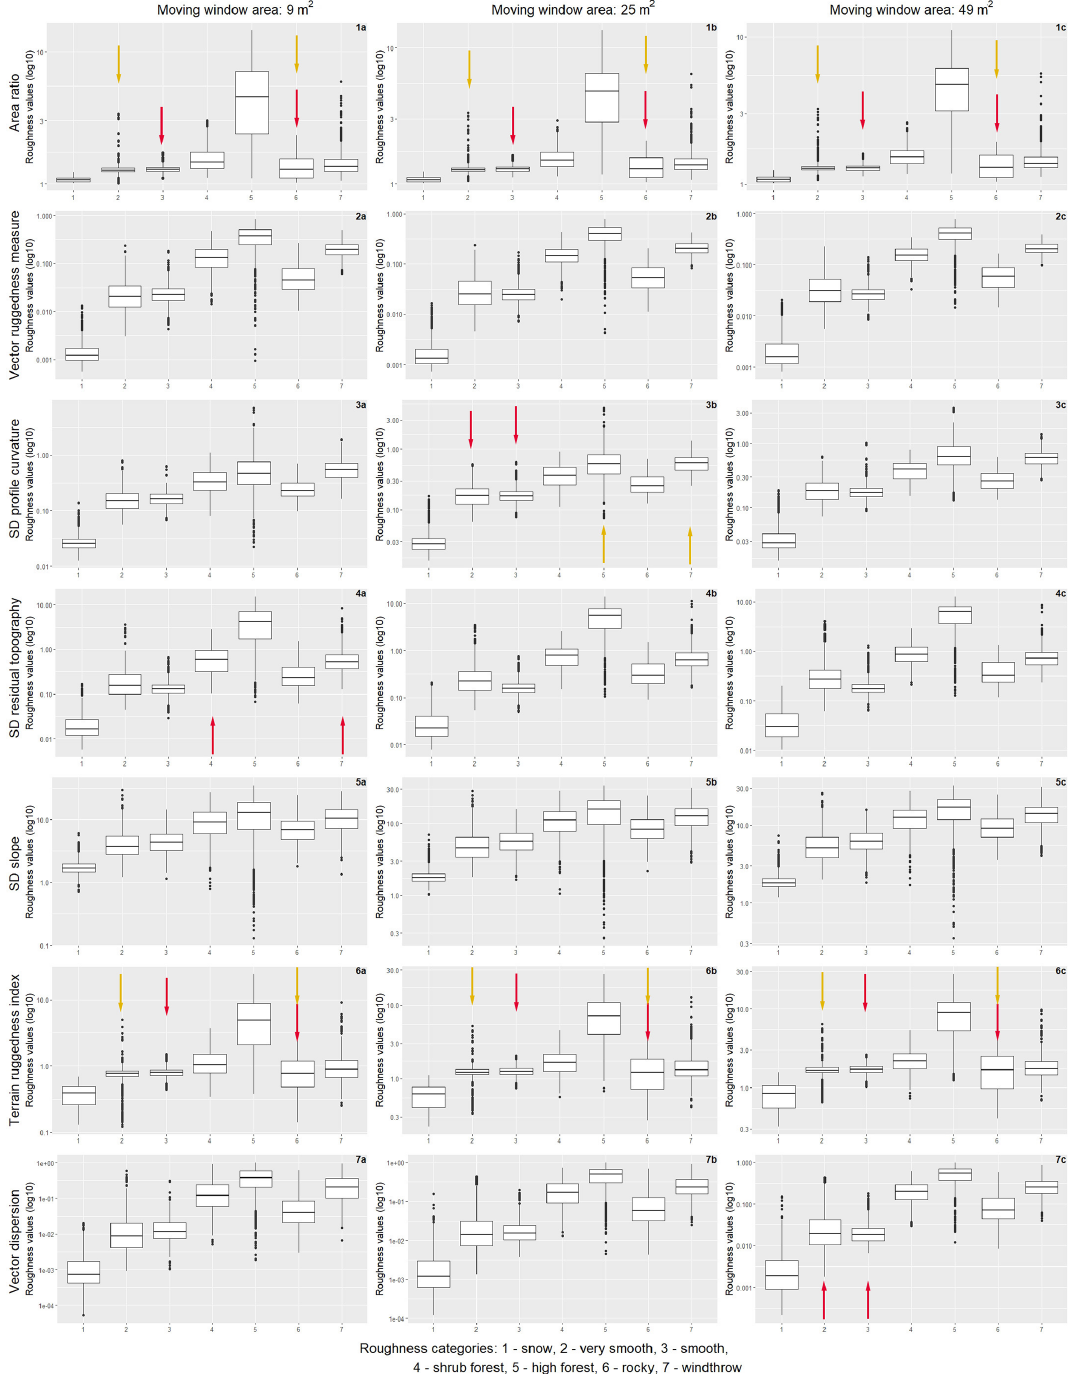
Figure A2. Distribution of roughness values according to different roughness categories (1 – snow, 2 – very smooth, 3 – smooth, 4 – shrub forest, 5 – high forest, 6 – rocky, 7 – windthrow) for seven algorithms (area ratio, vector ruggedness measure, SD of profile curvature, SD of residual topography, SD of slope, terrain ruggedness index and vector dispersion) for the spatial resolution of 0.5m. Red and yellow arrows show the overlapping distribution for a pair of categories that the given algorithm fails to